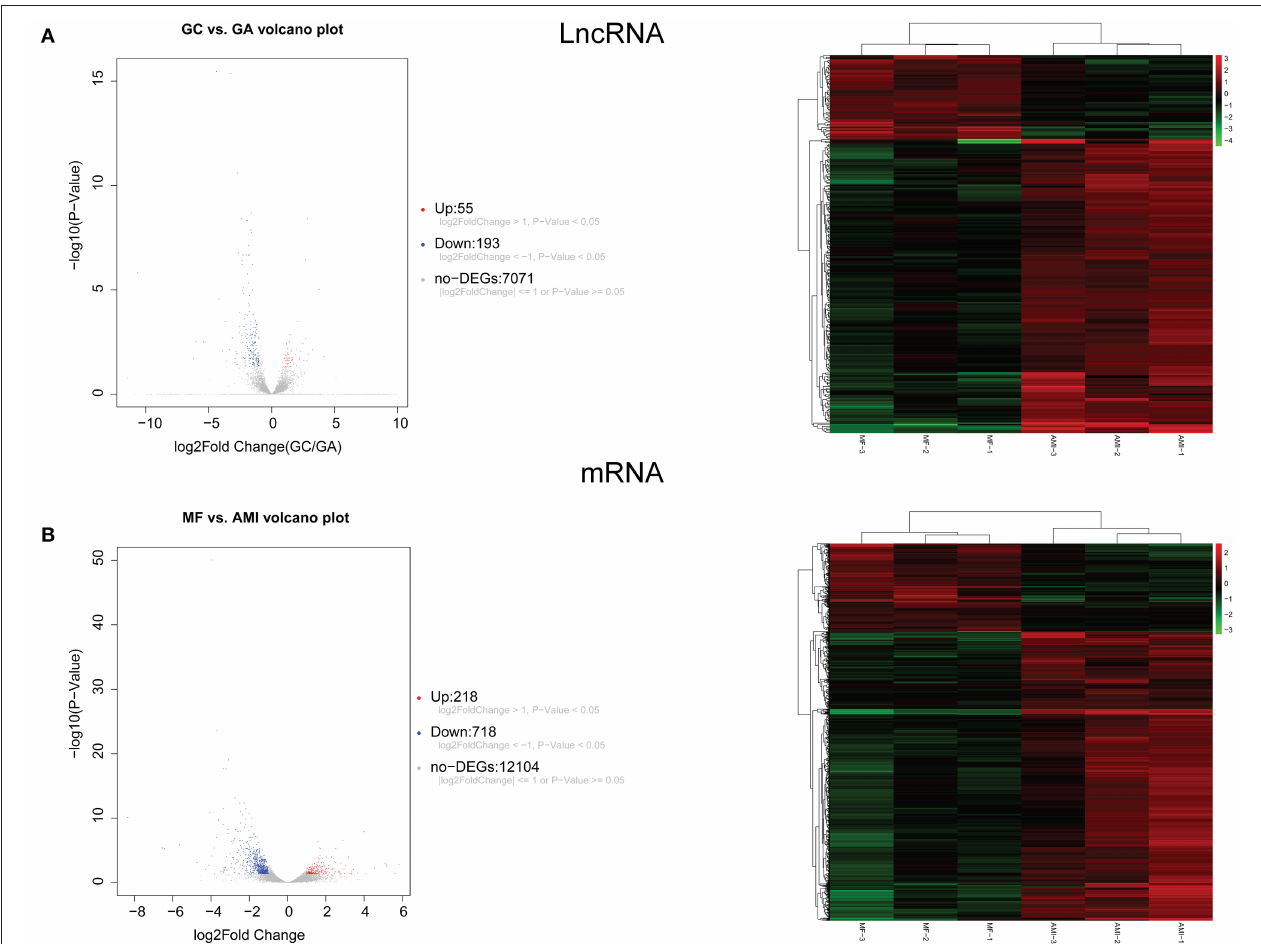
FIGURE 1 | The volcano plot and hierarchical clustering diagram of lncRNAs (A) and mRNAs (B) in MF vs. AMI. In the volcano, the x -axis and y -axis present Log2 fold change and –log10 p -value, respectively. Red and blue color represent upregulation and downregulation, respectively. In the hierarchical clustering diagram, the diagram presents the result of a two-way hierarchical clustering of lncRNAs/mRNAs and sample. Each row represents a differentially expressed lncRNA/mRNA, and each column represents a sample. Differentially expressed lncRNAs/mRNAs clustering tree is shown on the top right corner. The color scale illustrates the relative level of differentially expressed genes: red, below the reference channel; green, higher than the reference.